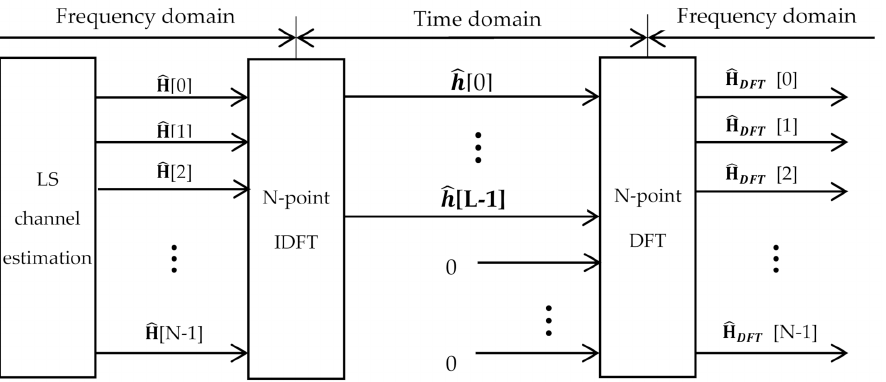
Figure 3. DFT-based channel estimation block